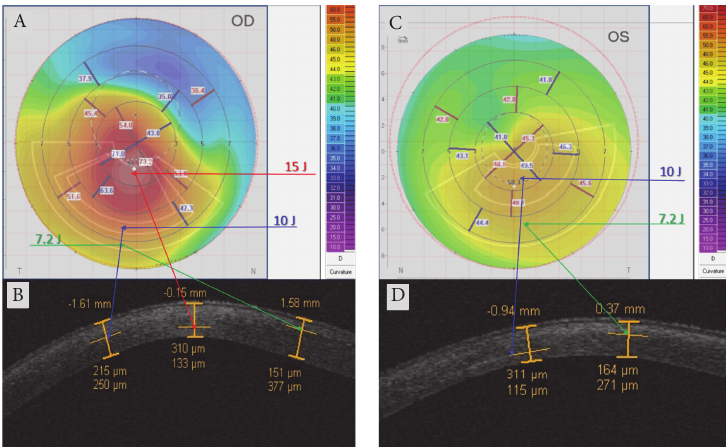
Figure 5: Topography-guided ACXL treatment programs according to different KC severity. (a) shows a 3-Zone topography-guided ACXL treatmentplanningaccordingtocornealcurvatures.PostoperativeOCTscansonemonthaftertreatment(b)revealedatripledemarcationline according to the three different exposure times and energy doses: 7.2J/cm 2 in the peripheral KC flattest area 48D and under (depth 151 𝜇 m), green arrows (8min UV-A exposure); 10J/cm 2 in the intermediate area between 48 and 52 D (depth 215 𝜇 m), blue arrows (11min UV-A exposure); 15J/cm 2 in the steepest area (depth 310 𝜇 m), red arrows (16min UV-A exposure). (c) shows a 2-Zone topography-guided ACXL treatment with 7.2 (green arrows) and 10 J/cm 2 (blue arrows) E doses treatment planning. OCT scan performed one month after treatment (d) revealed a double demarcation line according to the different exposure times and doses delivered according to corneal curvatures, reaching a demarcation line depth of 164 𝜇 m in the peripheral area treated with 7.2 J/cm 2 for 8 min of UVA exposure (green arrow) and 311 𝜇 m in the steeper paracentral area treated with 10J/cm 2 for 11min of UV-A exposure (blue